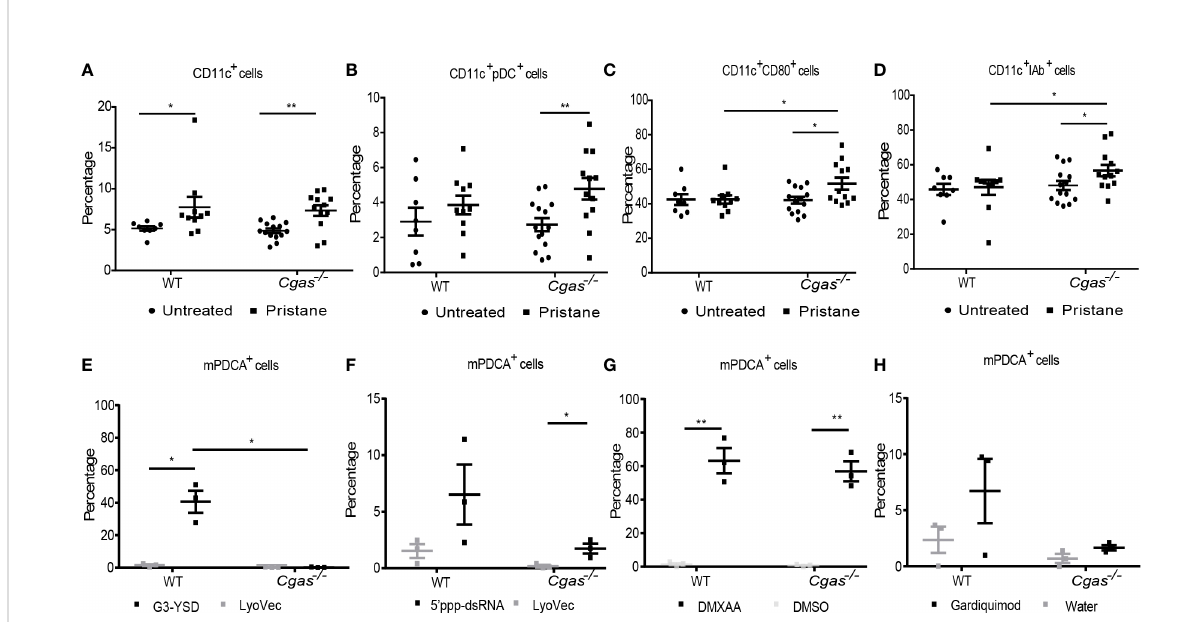
FIGURE 2 cGAS de fi ciency expands the activated dendritic cells and plasmacytoid dendritic cells in response to pristine. (A – D) Flow cytometry analysis of splenocytes isolated from WT and Cgas -/- mice at 8 months after pristane injection (n = 8-14 per group). Data are shown as the percentage of (A) CD11c + cells, (B) CD11c + PDCA + (plasmacytoid DC), (C) CD11c + CD80 + cells, and (D) CD11c + IAb + cells. (E – H) Bone marrow-derived dendritic cells (BMDCs) were differentiated with IL-4 and GM-CSF for 5 days. Flow cytometry analysis shows the percentage of pDCs after (E) G3-YSD activation, (F) 5 ’ ppp-dsRNA activation, (G) DMXAA activation, and (H) Gardiquimod activation for 24 h (n = 3 per group). Data are shown as the mean ± SEM. *p < 0.05, **p <